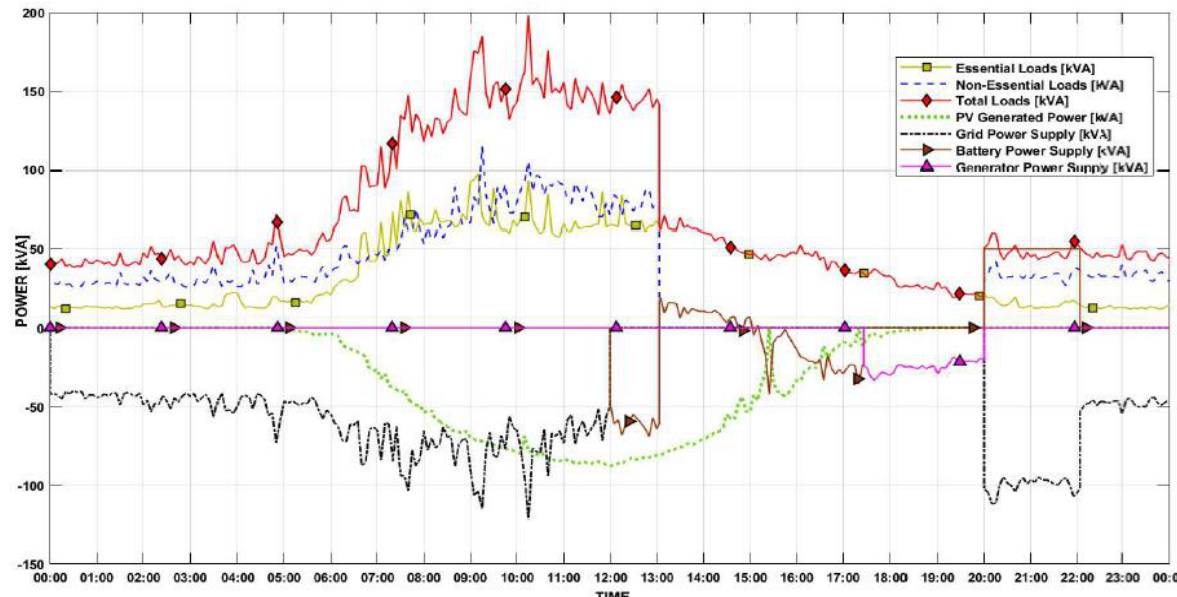
Figure 22. The behavior of MCAST micro-grid integrated with optimum-sized energy storage during an 8-h power cut at 12 p.m.